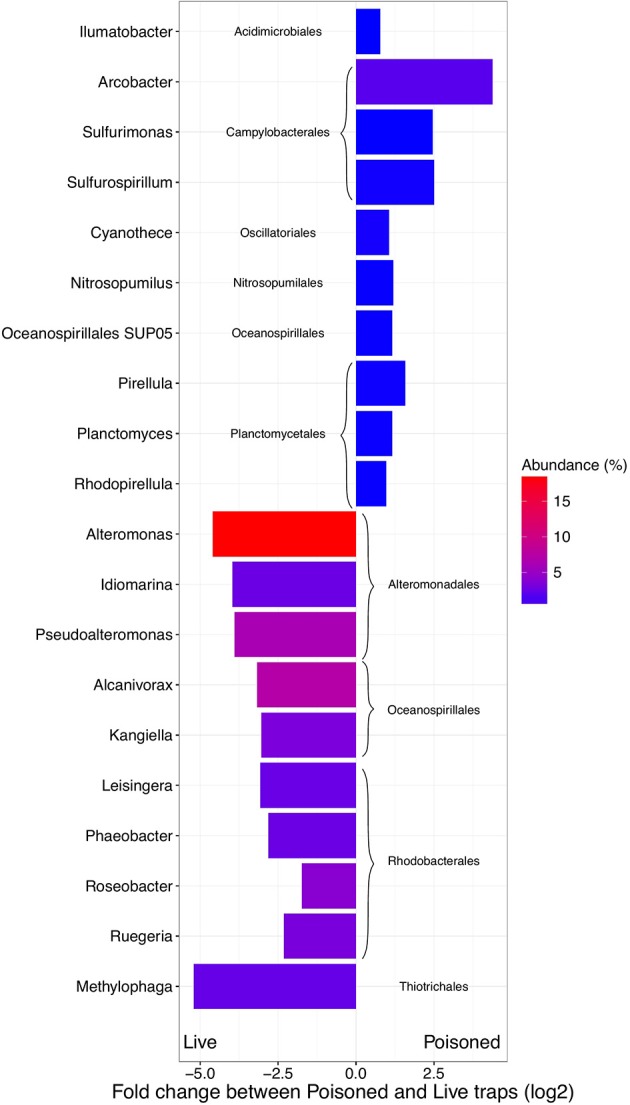
Difference in abundance (expressed as fold change between normalized taxonomic counts of read matches to the RefSeq database) in the initial and processed community for the 10 most abundant significantly enriched archaeal and bacterial genera in poisoned and live traps, respectively. The color represent average abundance in all traps (expressed as percentage of mean normalized counts in all traps).